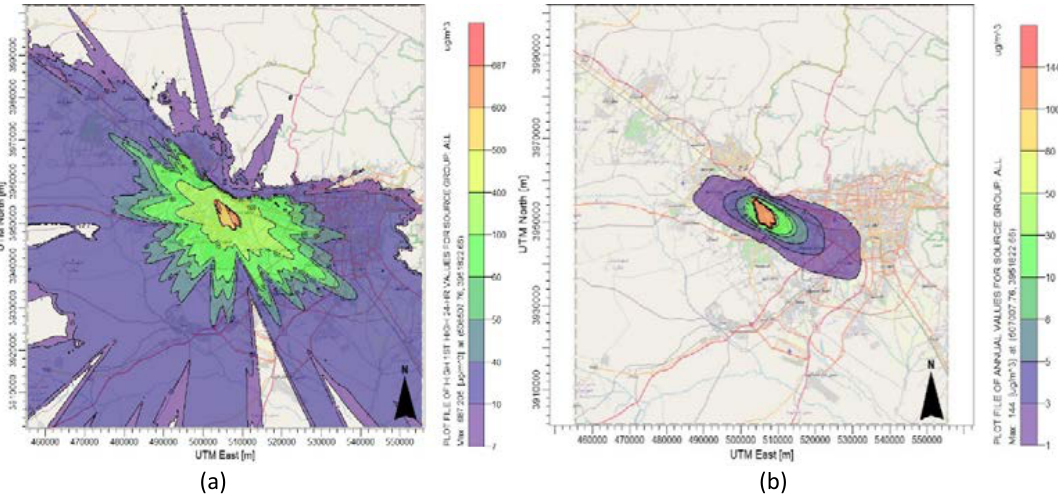
Fig. 7: Dispersion of TSP from the sand and gravel product plants: (a) 24-hour average and (b) annual average Table 6: Maximum concentrations of PMs emitted from the sand and gravel product plants